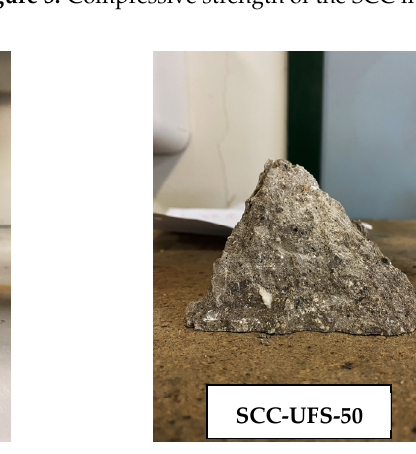
Figure 5. Compressive strength of the SCC mixes.